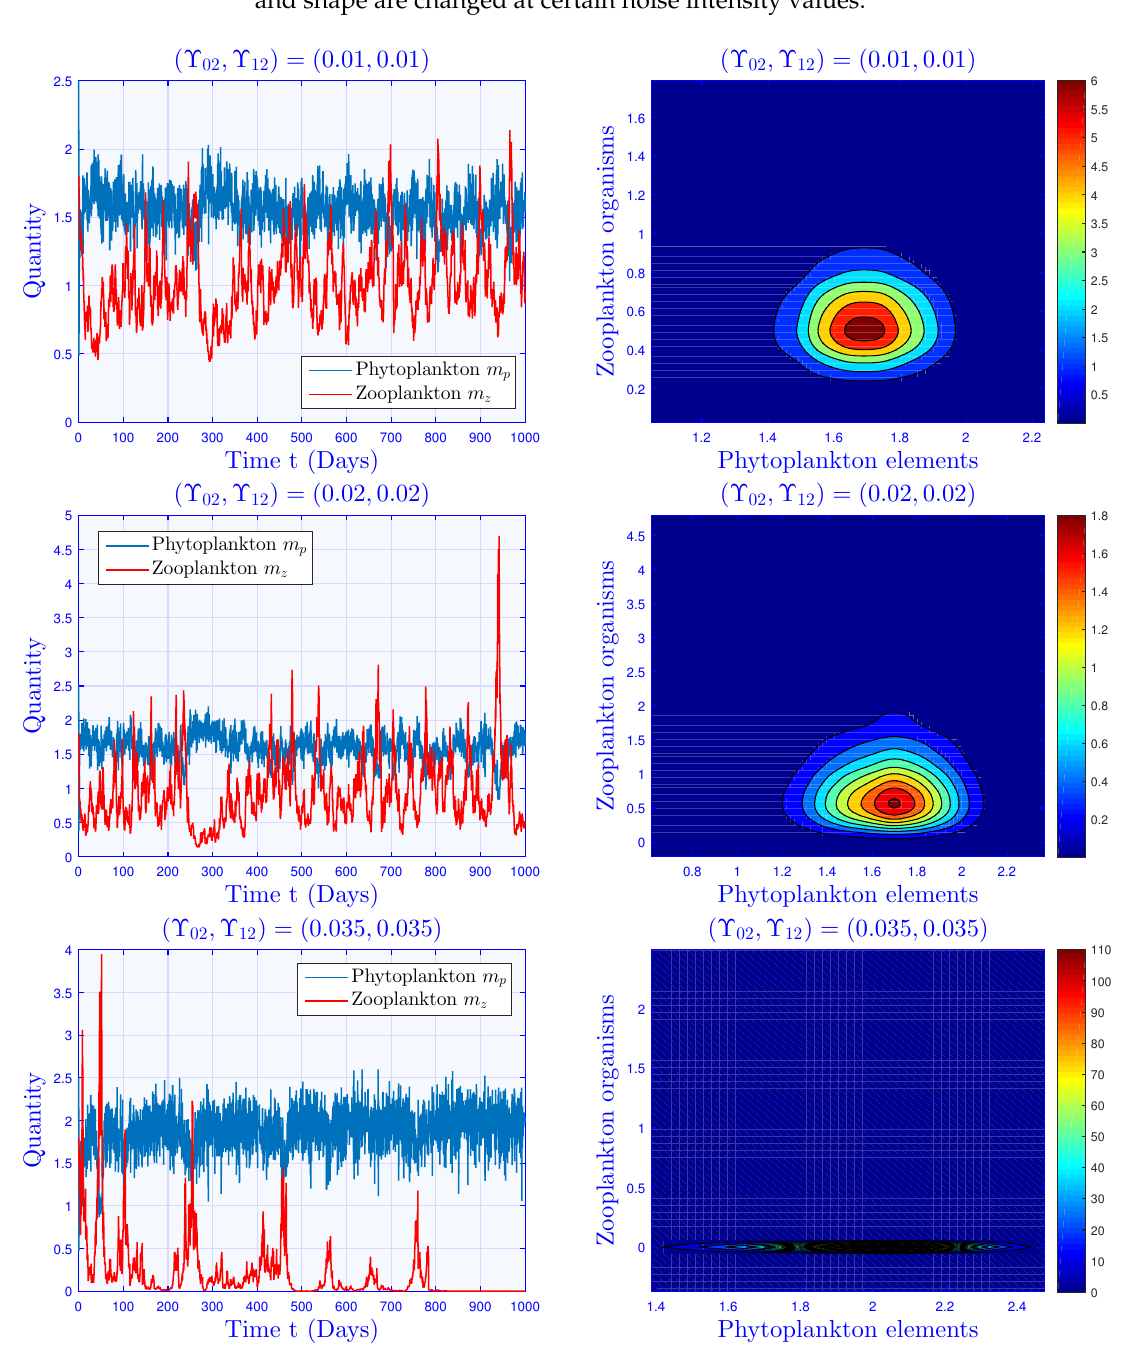
Figure 6. Illustration of the dynamic transition induced by cubic noise. From 0.01 to 0.035, we pass from the case of stationarity to the case extinction scenario. The fixed deterministic coefficients are chosen from Table 1 (Test 1). For random amplitudes, we select Υ 00 = 0.17, Υ 01 = 0.1, Υ 10 = 0.13, Υ = 0.112, Ξ ( r ) = 0.1, Ξ ( r ) = 0.01, Ξ ( r ) = 0.1, Ξ ( r ) = 00 11 01 10 11